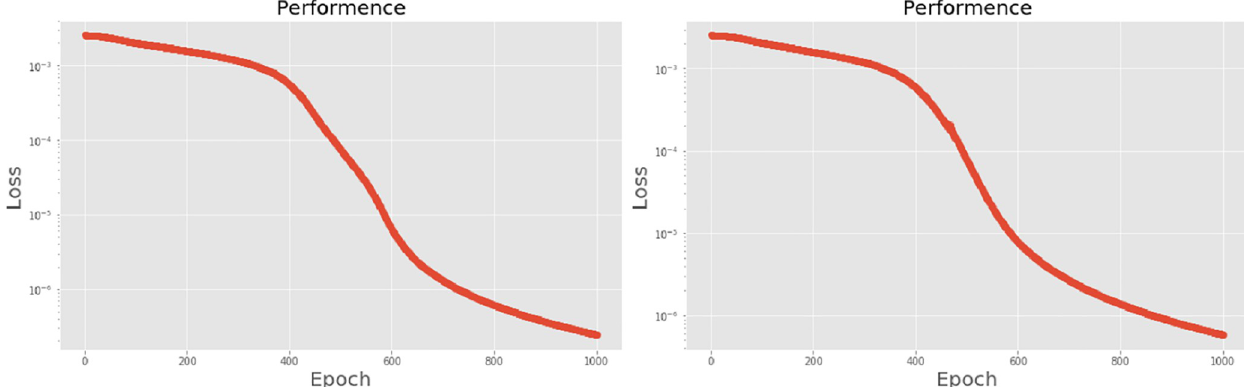
Fig 20. (a) The graph shows the performance of MFCC-DNN-24-layer model; (b) The graph shows the performance of MFCC-PCA-DNN-24-layer